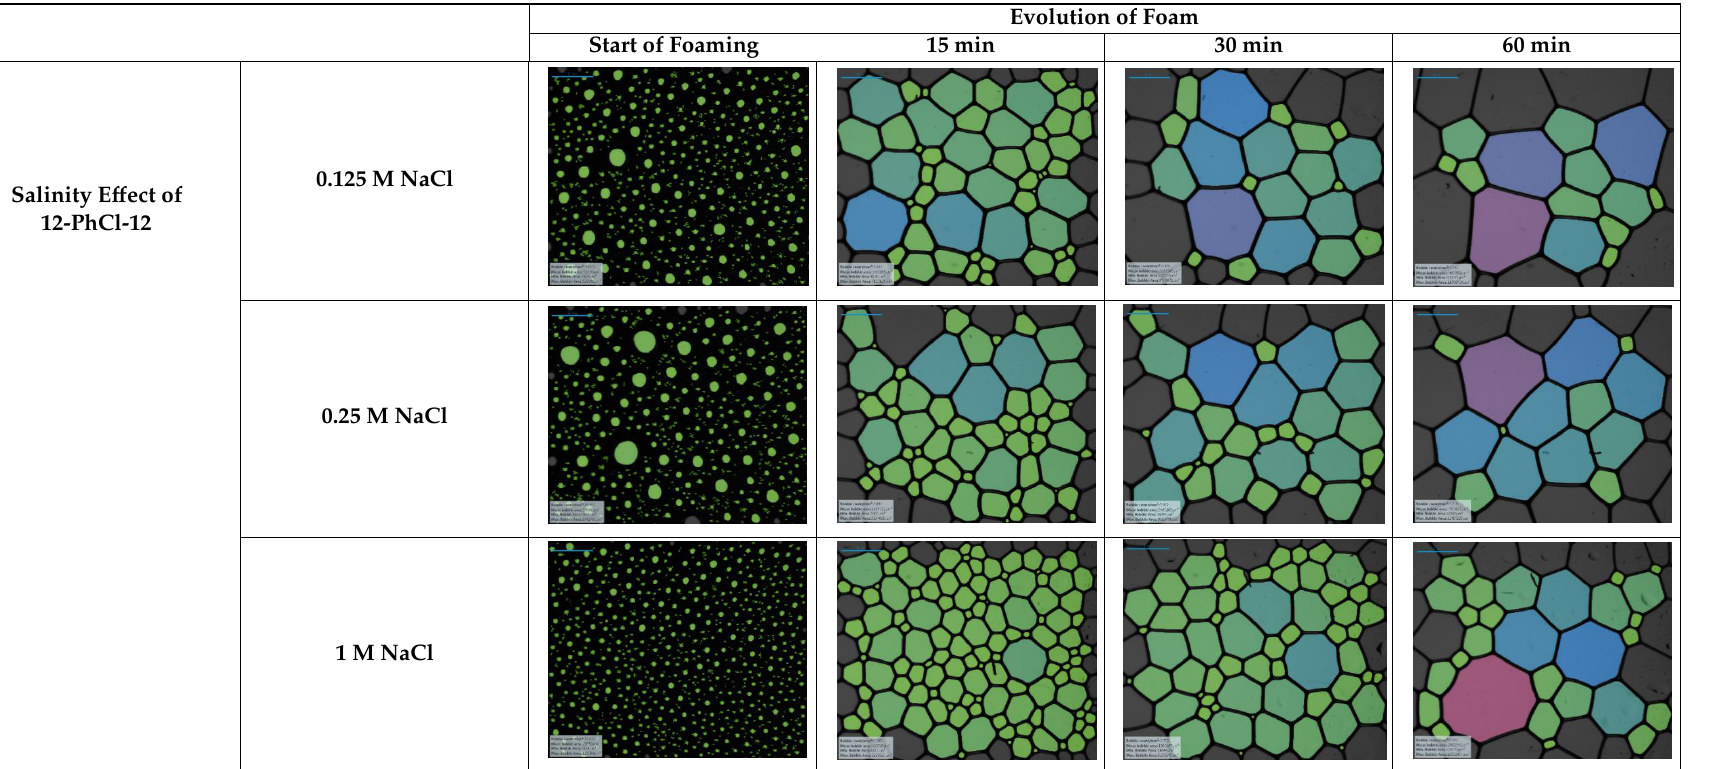
Table 3. Image view of bubble count and size at different times with salinity effect in 12-PhCl-12.